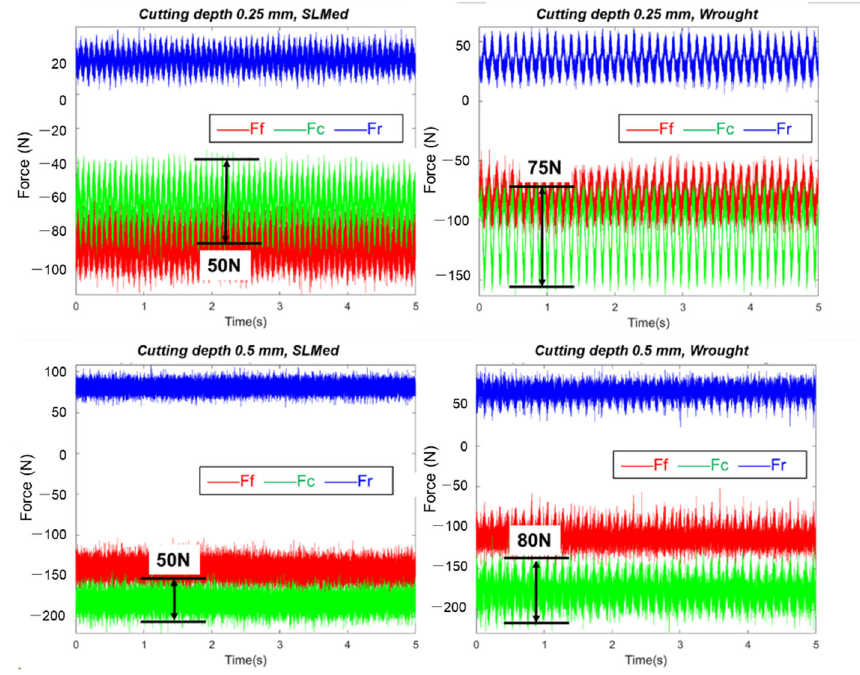
Figure 4. Cutting forces when machining wrought and SLMed Ti6Al4V workpieces at the cutting parameters of 0.2 mm/rev and 80 m/min.